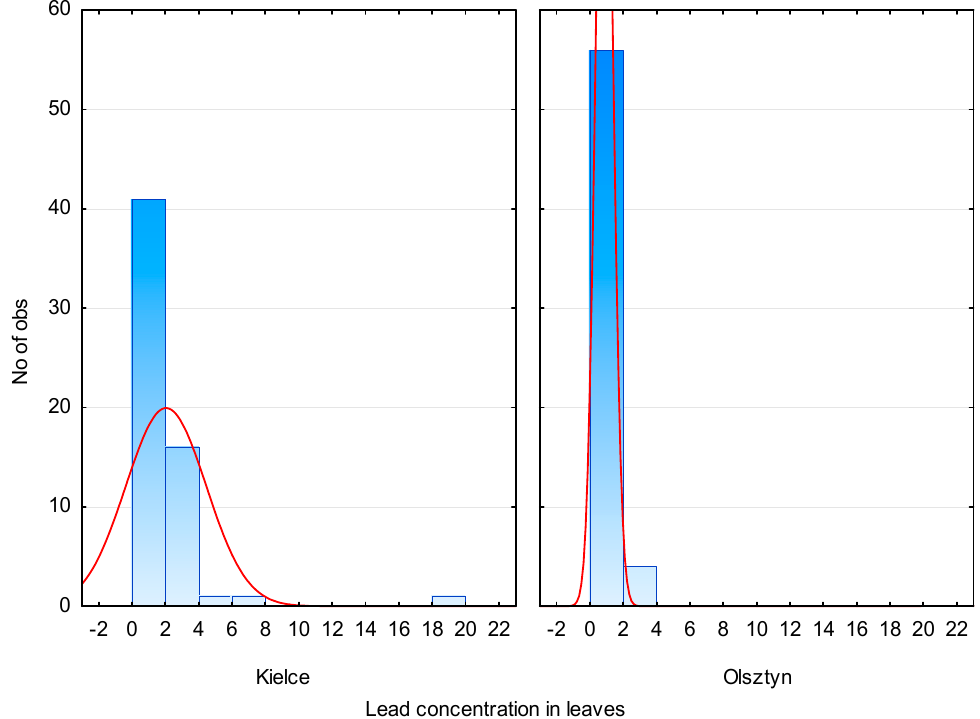
Figure 4. Diversification of lead content in the common dandelion’s leaves from Kielce and Olsztyn. The maps of lead concentrations in the soils and common dandelions show a large spatial variability of parameters in both Kielce and Olsztyn (Figures 5 and 6).